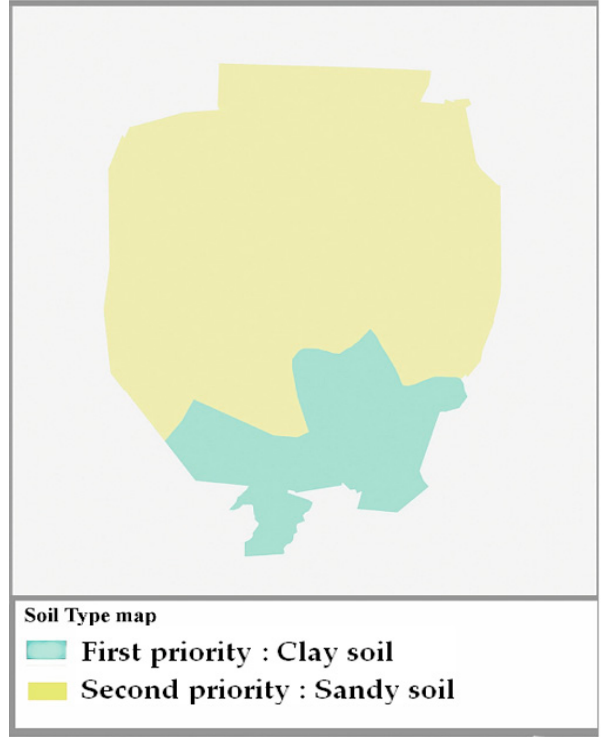
Figure 8. The soil type map of Hamedan based on the sub-criteria measures in Table 1.